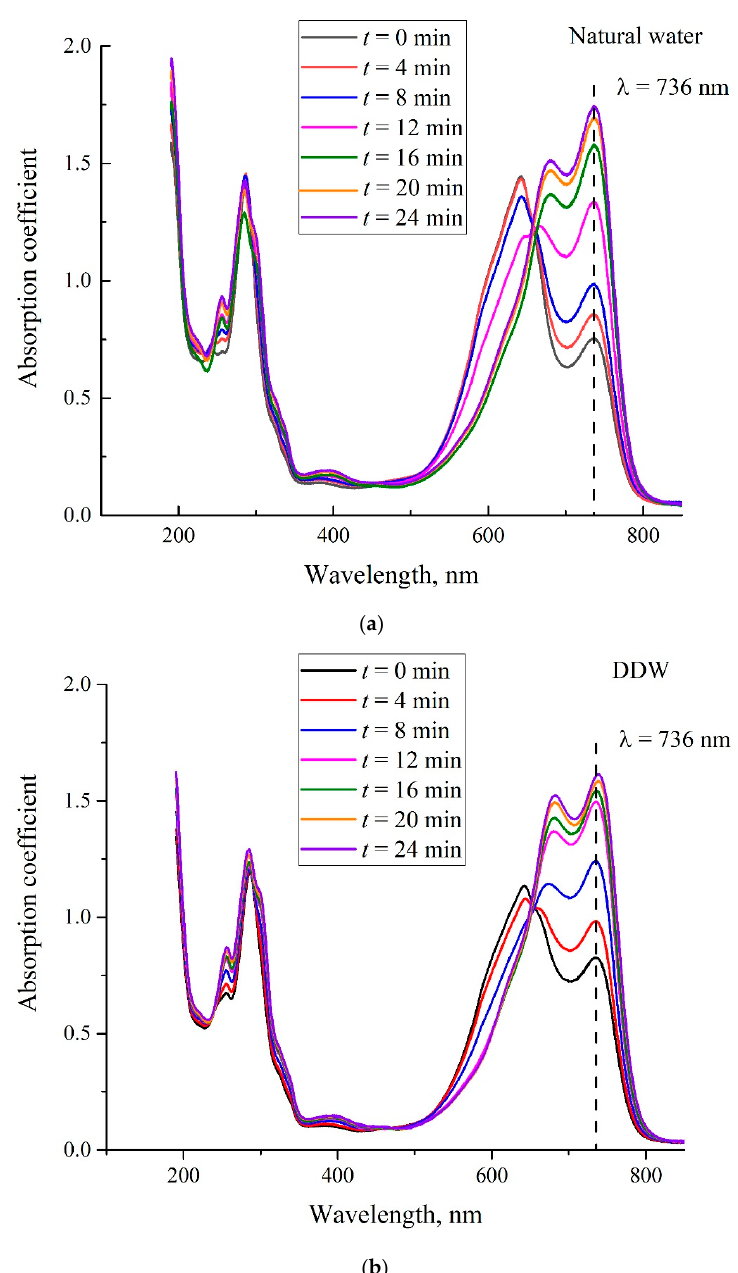
Figure 7. Absorptivity spectra of Nafion plate soaked in the MB solution with concentration 0.015 mg/mL. The inset shows the soaking time t . Panel ( a )—the MB solution is based on natural water. Panel ( b )—the MB solution is based on DDW.